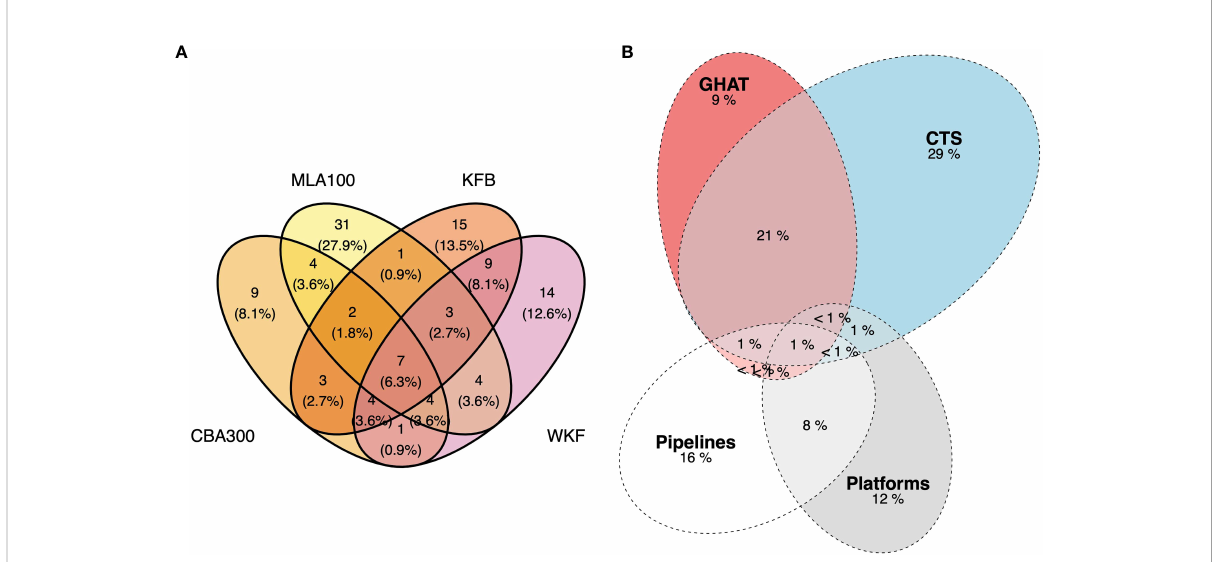
FIGURE 12 (A) Venn diagram showing the number and percent of shared species among the pipelines CBA300 and MLA100 and platforms KFB and WKF, (B) Euler diagram showing the percent overlap between retained catch species from commercial fi sheries with oil and gas pipeline and platform communities. Species data included imagery analysis from Remotely Operated Vehicle surveys of two pipelines and two steel pile jackets and cumulative catch data from